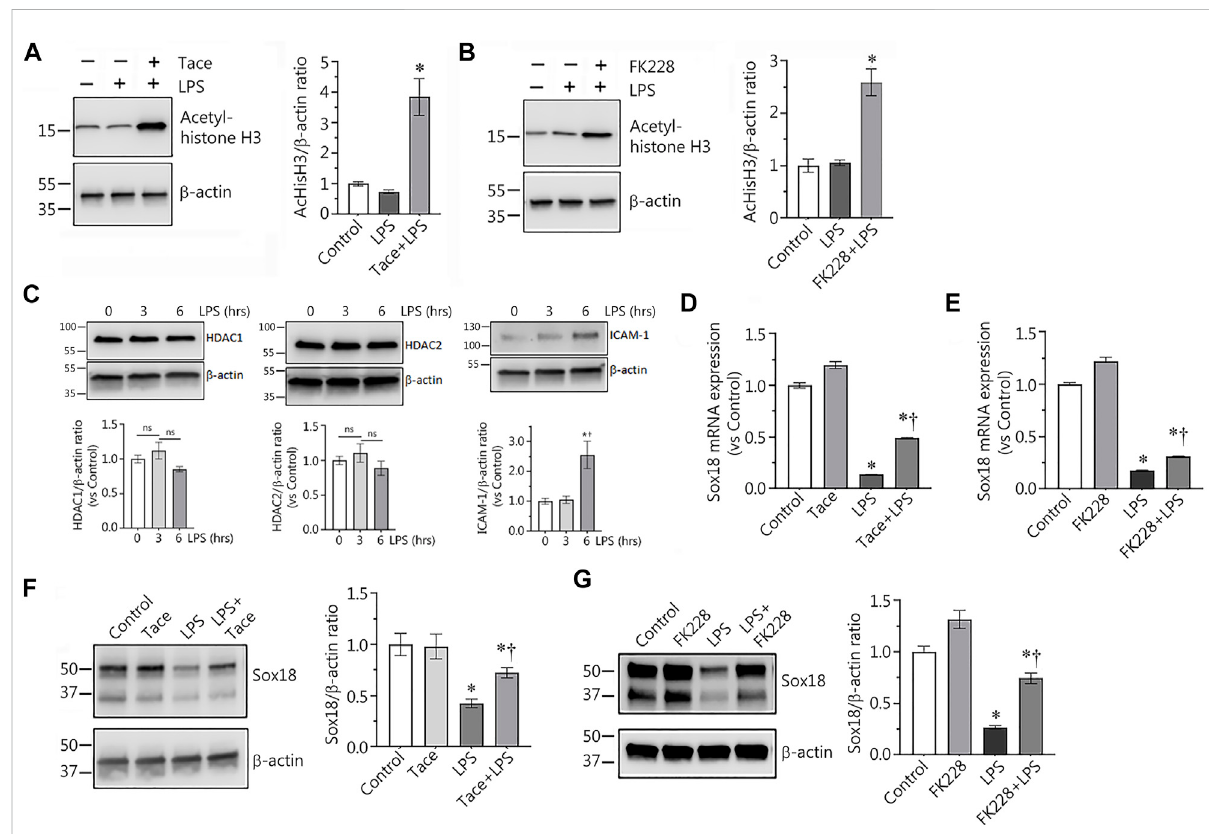
FIGURE 2 Selective inhibitors of HDAC1 and HDAC2 signi fi cantly protect expression of Sox18 at mRNA and protein levels in LPS-challenged in cultured human lung microvascular endothelial cells. In HLMVEC, pharmacological inhibition of HDACs 1 or 2 leads to accumulation of acetylated histone H3 demonstrating speci fi c effects of the inhibitors (A,B) . LPS challenge affected neither HDAC1 nor HDAC2 protein levels, however, ICAM-1 expression is signi fi cantly increased (C) . At the same time, the inhibitors signi fi cantly attenuate the LPS-induced repression of Sox18 mRNA expression (D,E) andSox18 proteinlevels (F,G) .Thecells werepre-treatedwiththeinhibitors orvehiclefor30 minthenchallengedwith2EU/mlLPS for 6 h. Data are mean ± SEM, n = 3 – 6. * p < 0.05 vs . Control; † p < 0.05 vs . LPS